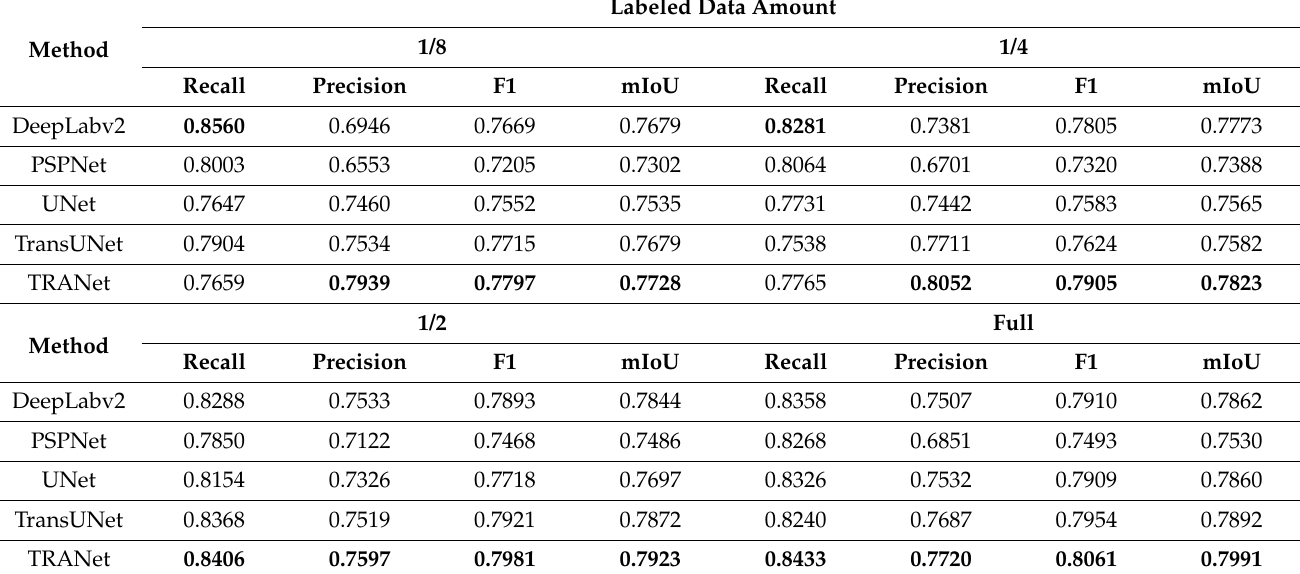
Table 4. Building extraction accuracies obtained with different quantities of labeled data on the GID. The highest accuracy is displayed in